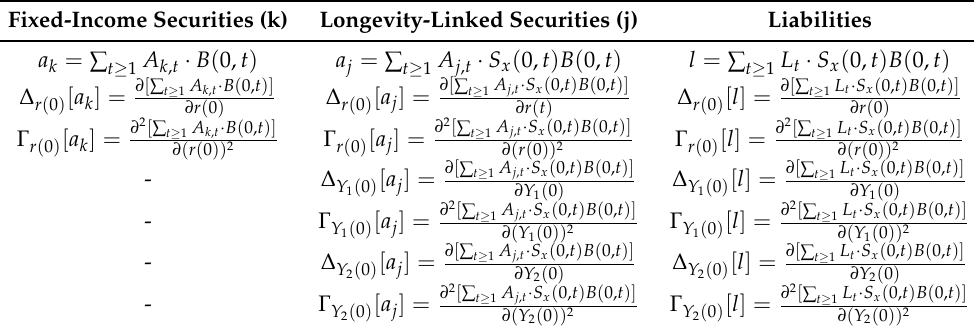
Table 5. Delta and Gamma for Asset and Liability Cash